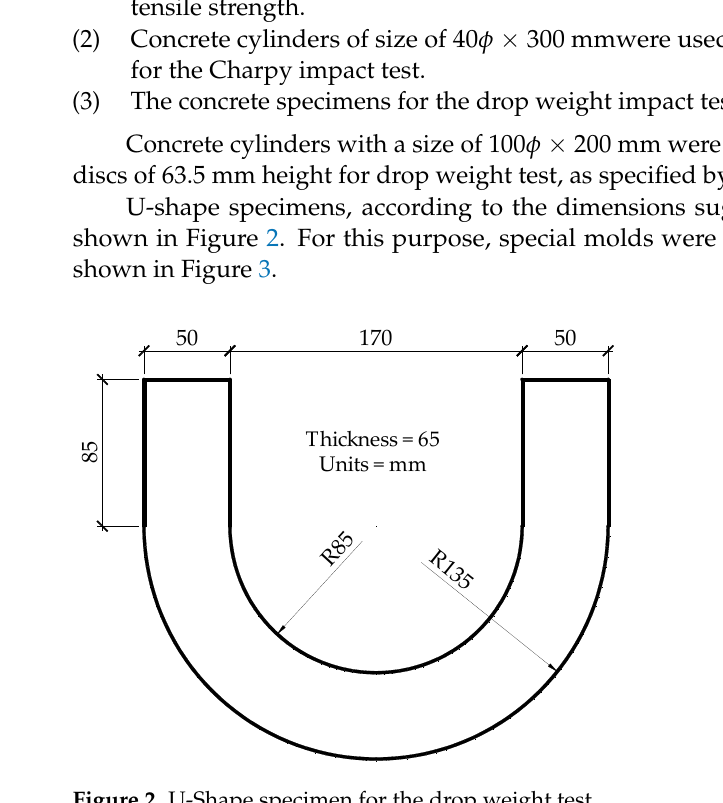
Figure 2. U-Shape specimen for the drop weight test